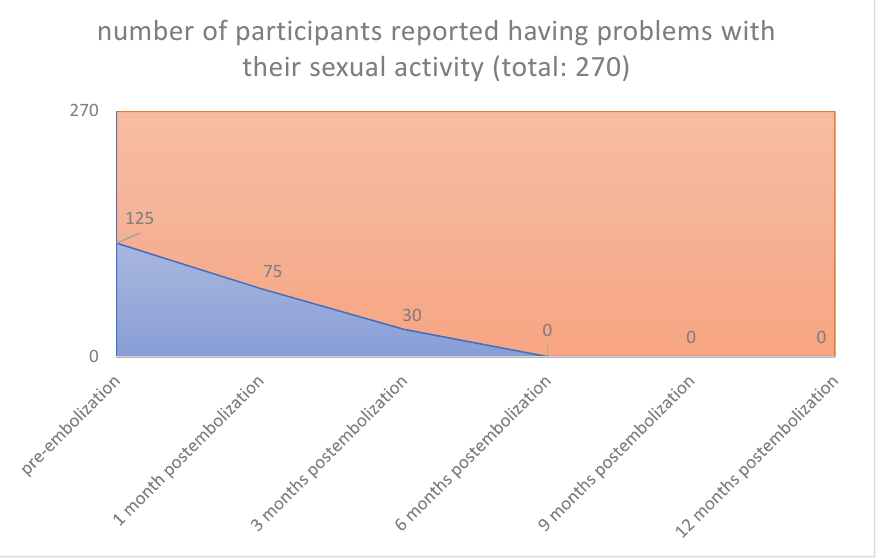
Figure 7. Sexual activity: Pre-embolization 125 from 270 participants reported having problems with their sexual activity. 1 Month 75 from 125 participants reported having problems with their sexual activity. 3 Months 30 from 125 participants reported having problems with their sexual activity. 6 Months 0 from 125 participants reported having problems with their sexual activity. 9 Months 0 from 125 participants reported having problems with their sexual activity. 12 Months 0 from 125 participants reported having problems with their sexual activity.